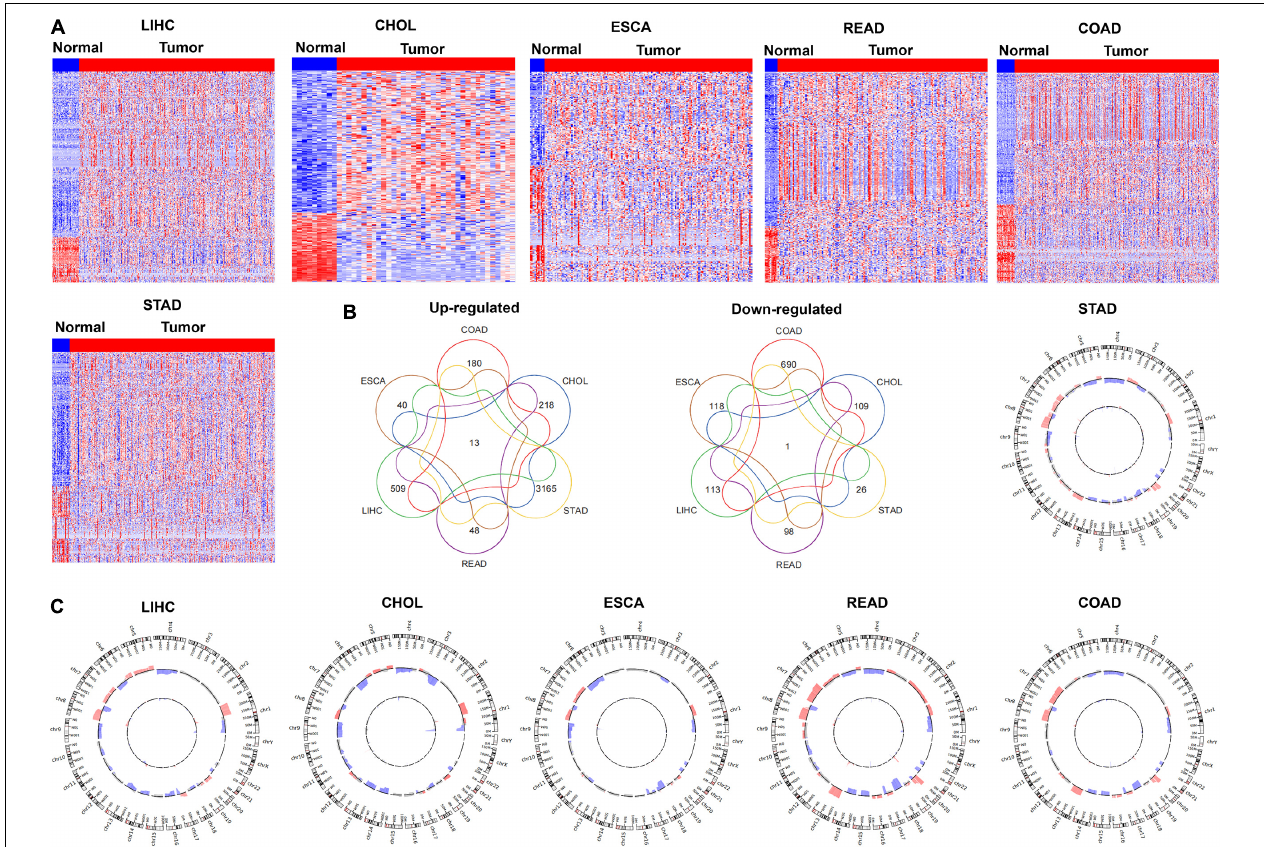
FIGURE 1 | The expression profiles of pseudogenes in digestive tract cancers. (A) Heatmap of the differentially expressed pseudogenes expression in digestive tract cancers was analyzed using the TCGA datasets (LIHC, CHOL, ESCA, READ, COAD, and STAD). (B) Venn diagrams showing pseudogenes commonly upregulated and downregulated in the TCGA datasets (LIHC, CHOL, ESCA, READ, COAD, and STAD). (C) Pseudogenes with copy number amplification and deletion in digestive tract cancers were analyzed in TCGA datasets (LIHC, CHOL, ESCA, READ, COAD, and STAD).